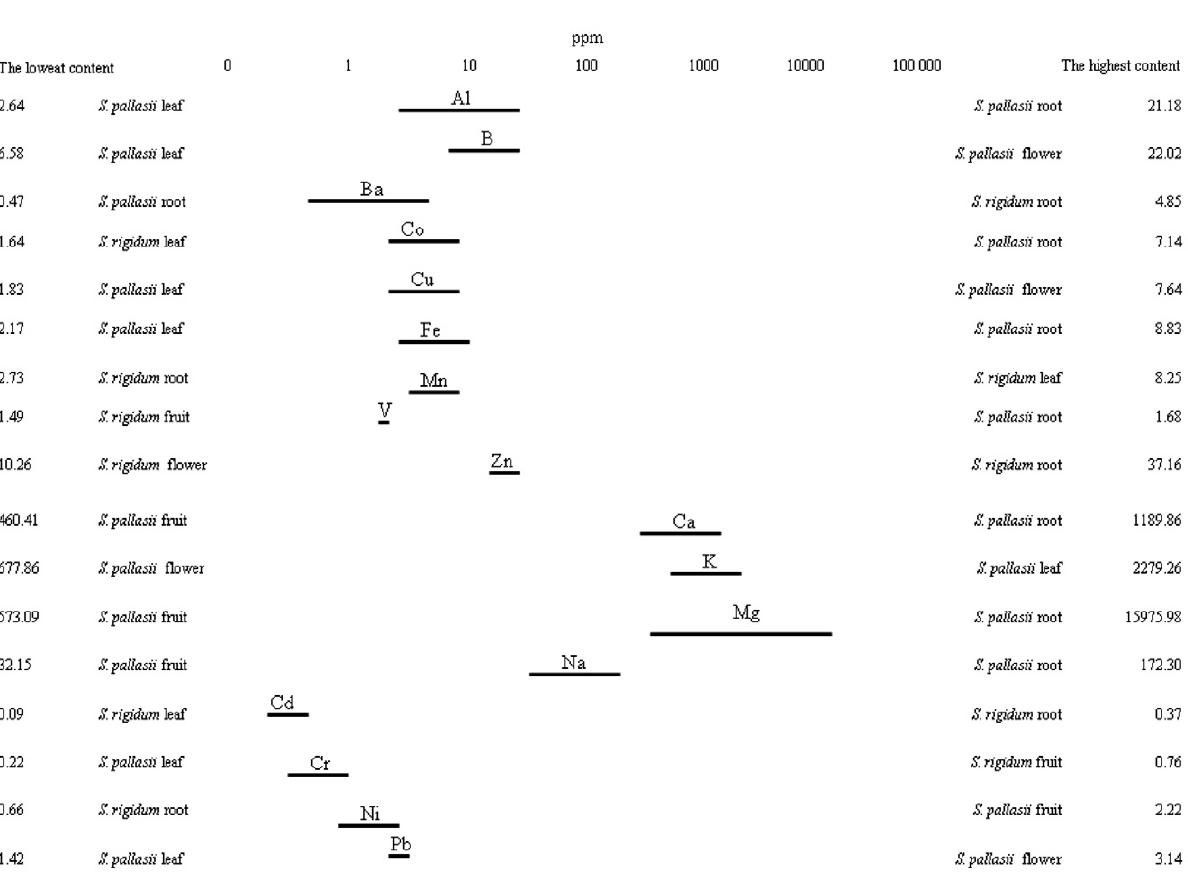
Figure1. Contents of Al, B, Ba, Co, Cu, Fe, Mn, V, Zn, Na, Mg, Ca, K, Cd, Cr, Ni, and Pb in leaf, flower, fruit, and root of the plant species S. rigidum and S.